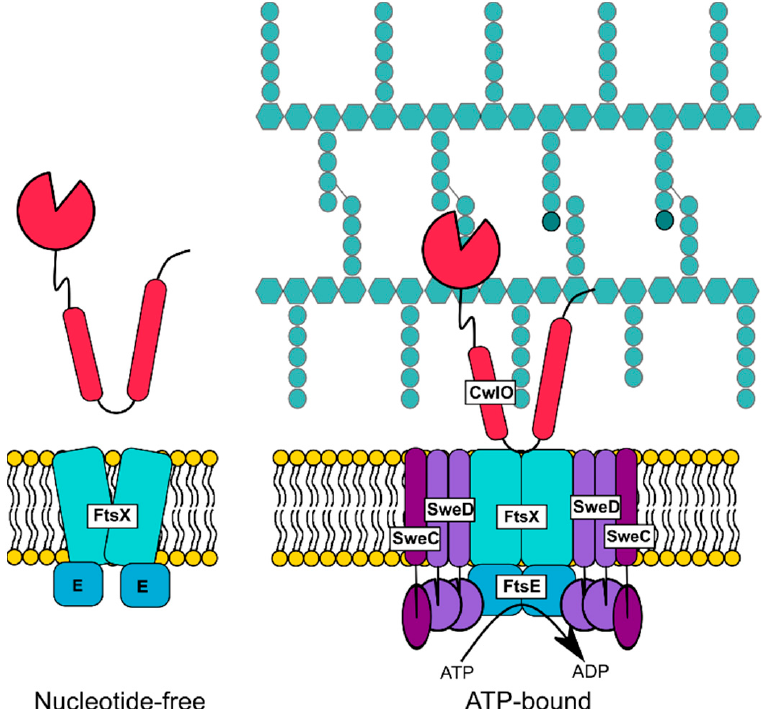
Figure 2. The FtsEX system of B. subtilis . The type VII ABC transporter FtsEX is an essential activator of the major cell wall hydrolase CwlO in B. subtilis . ATP hydrolysis by FtsE in the cytoplasm is proposed to result in conformational changes of FtsX which allows direct interaction with CwlO and subsequent regulation of its D-L-endopeptidase activity, and the complex is relaxed when in the nucleotide free state. The complex resides in the membrane together with SweC and SweD, that act as essential cofactors (adapted from [99]).